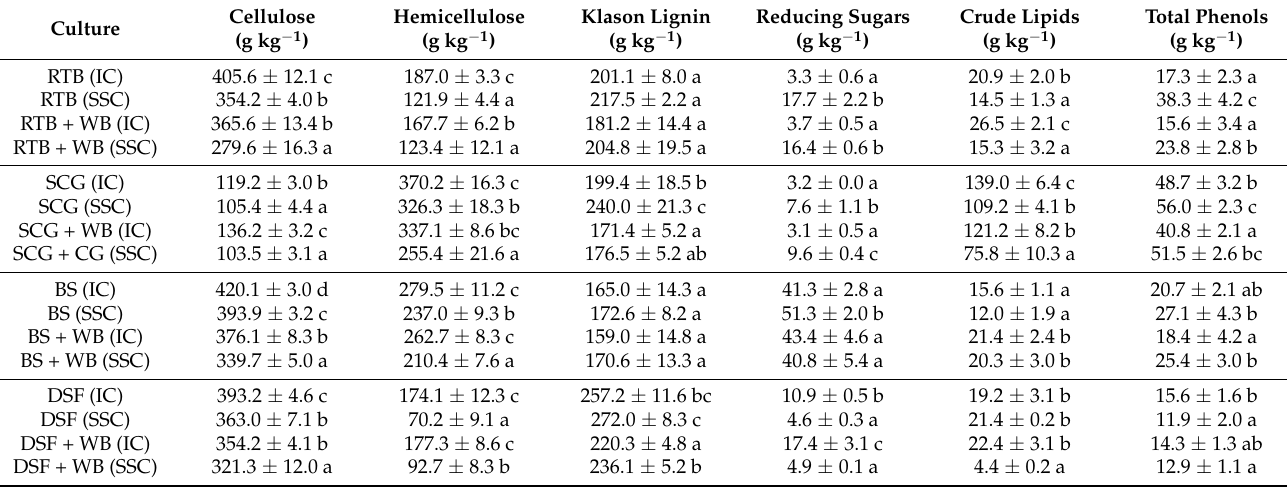
Table 3. Contents of cellulose, hemicellulose, Klason lignin, reducing sugars, total phenols and crude lipids in non- inoculated incubation controls (IC) and 14-day-old A. olivimuriae solid-state cultures (SSC) on residual thistle biomass (RTB), spent coffee grounds (SCG), barley straw (BS) and digestate solid fraction (DSF) in the absence and in the presence of wheat bran (WB). Data represent the mean ± standard deviation of 4 replicates. Multiple pairwise comparisons were carried out within each matrix using the Tukey test, and identical letters denote that column means within each block were not significantly different ( p >